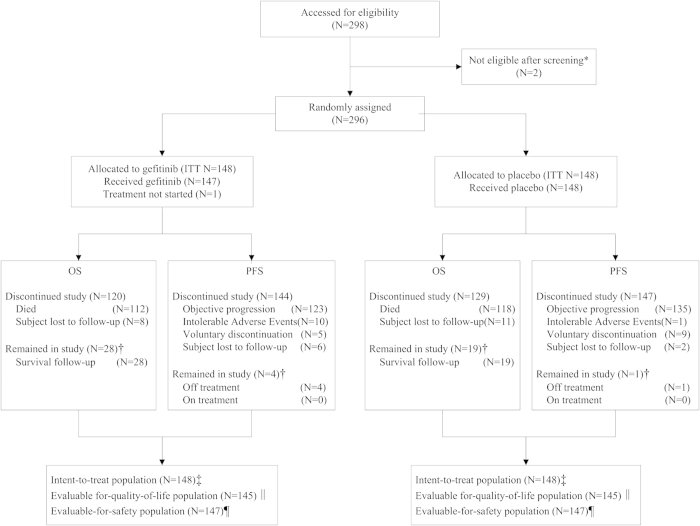
CONSORT diagram.OS = overall survival, PFS = progression free survival, ITT = intend-to-treat. (*)Two patients discontinued the study before randomization. (†) Cut off dates: June 17, 2014, for overall survival (OS) and progression-free survival (PFS). (‡) All patients who were randomly assigned to a study group were included in the intent-to-treat (ITT) analysis. (¶) All patients who received at least one dose of study treatment were included in the safety analysis. (‖)All patients received quality of life assessment at baseline were included in QoL analysis.